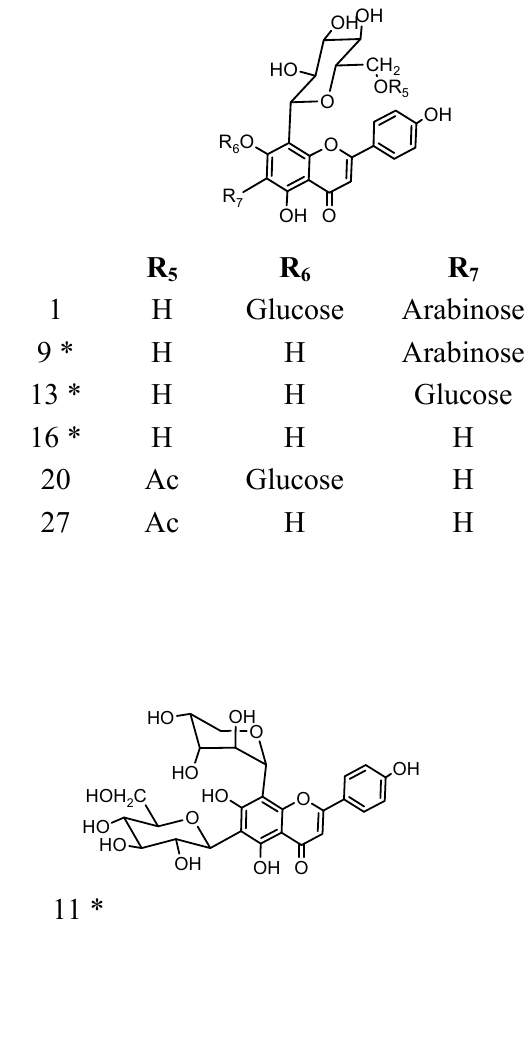
Figure 3. Proposed structures of luteolin and apigenin derivatives from Passiflora tripartita fruits identified by HPLC-DAD-ESI-MS.